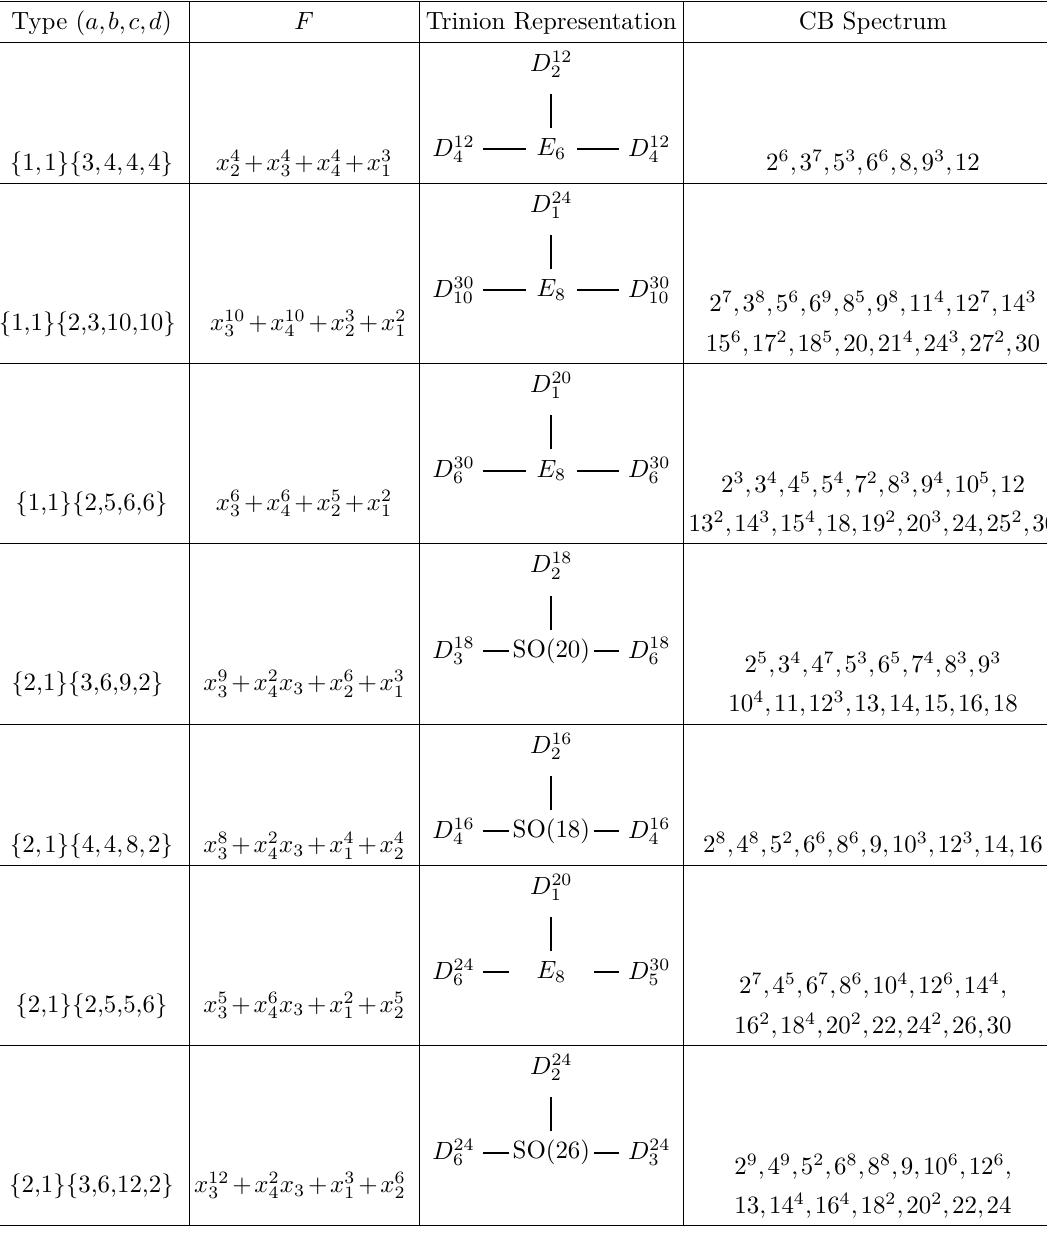
Table 5 . Models with integral spectrum and a 4d SCFT description as a D b